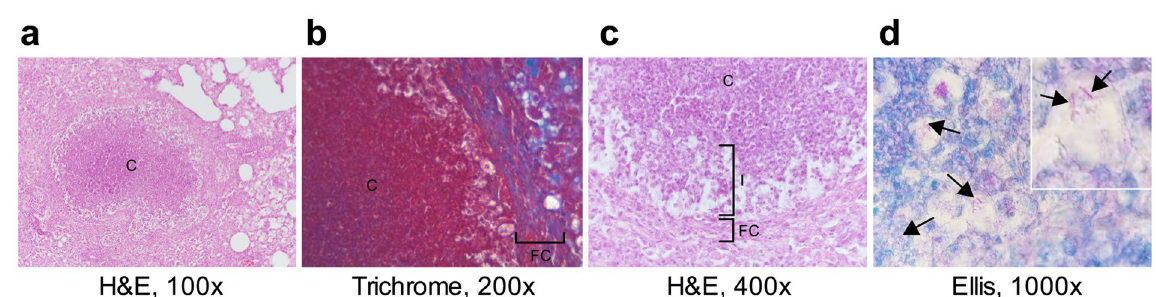
Figure 2. Nos2 − / − mice with TB form pulmonary caseous lesions with fibrous encapsulation and infected cells. ( a – d ) Lung sections of Nos2 − / − mice 84 days post-intradermal M. tuberculosis infection. H&E, Trichrome and Ellis’ acid fast staining of caseous lesions are shown. ( a ) The caseous center is separated from the fibrous cuff consisting of blue-stained newly formed collagen fibers ( b ) by a layer of lighter-appearing cells ( c ) presumably including infected foamy macrophages. ( d ) Acid fast rod-shaped M. tuberculosis bacilli are stained pink (arrows). Abbreviations: C, caseation; I, intersection; FC, fibrous cuff; H&E, haematoxylin &